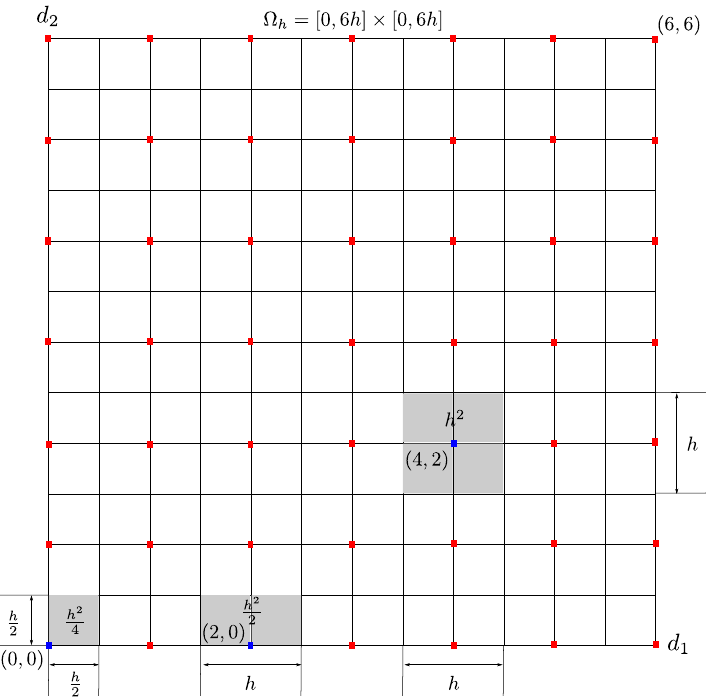
Figure 1. Example of 2D Ω discretization using a 6 × 6 grid with step h .